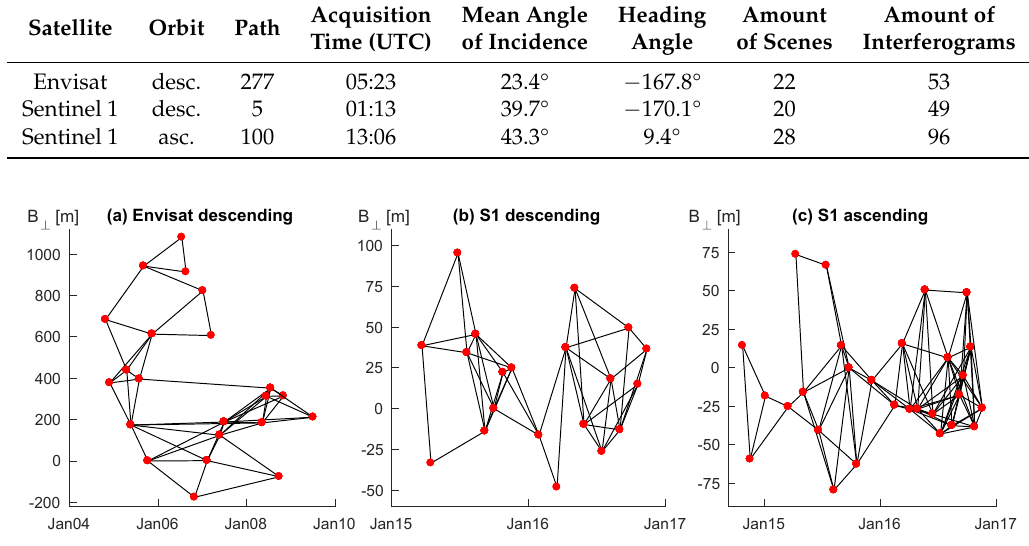
Figure 3. Small BAseline Subset (SBAS) networks after offending interferograms are removed for ( a ) Envisat descending; ( b ) Sentinel-1 descending and ( c ) Sentinel-1 ascending time series. Red dots denote the time of the image acquisitions, and black lines show the